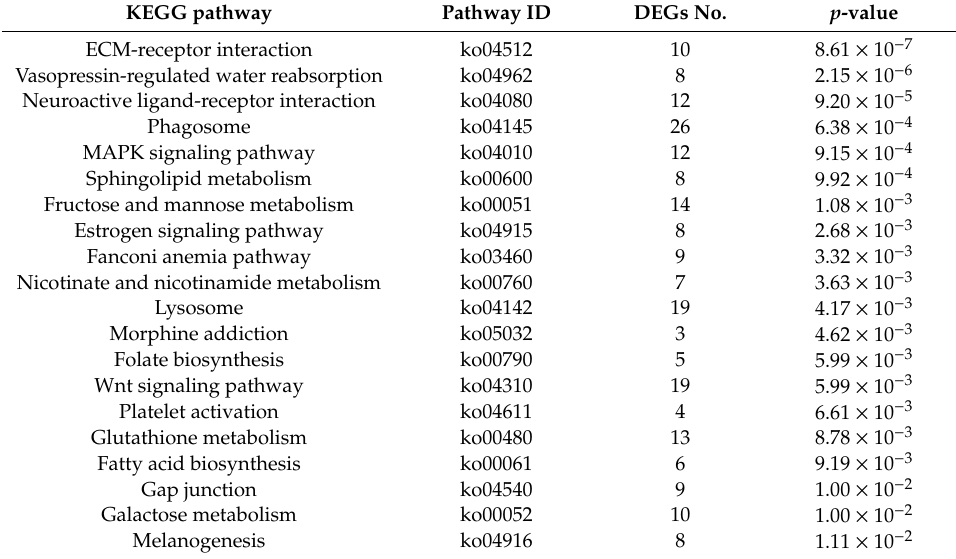
Figure 4. The enriched KEGG pathways of DEGs in TpA versus TpM: The numbers at the right of each column indicate the number of DEGs included in the corresponding pathway. The pathways were divided into six categories: “cellular processes”, “environmental information processes”, “genetic information processes”, “metabolism”, “human diseases,” and “organismal systems”. Criteria for statistical significance was p -value < 0.05. Table 3. Top 20 KEGG pathways significantly enriched by DEGs in TpA versus